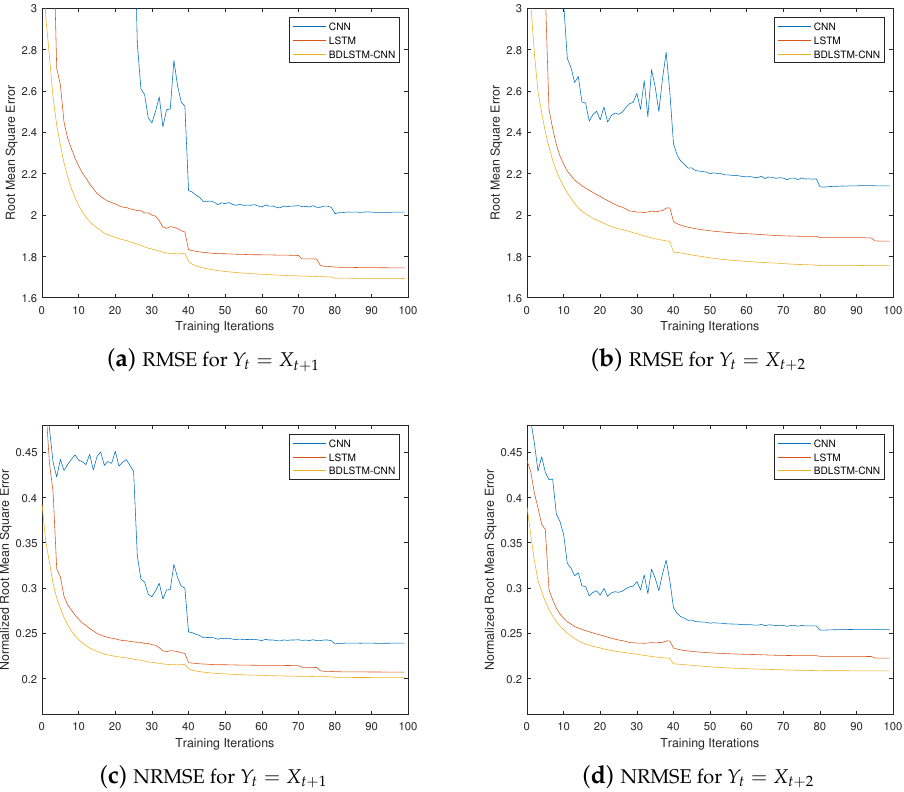
Figure 7. Performance Regarding RMSE and